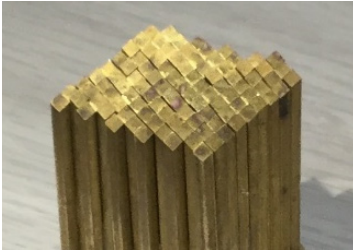
Figure 6. The flat SuperPin Plus corner cube retro-reflector (CCR) sample built by pin array.